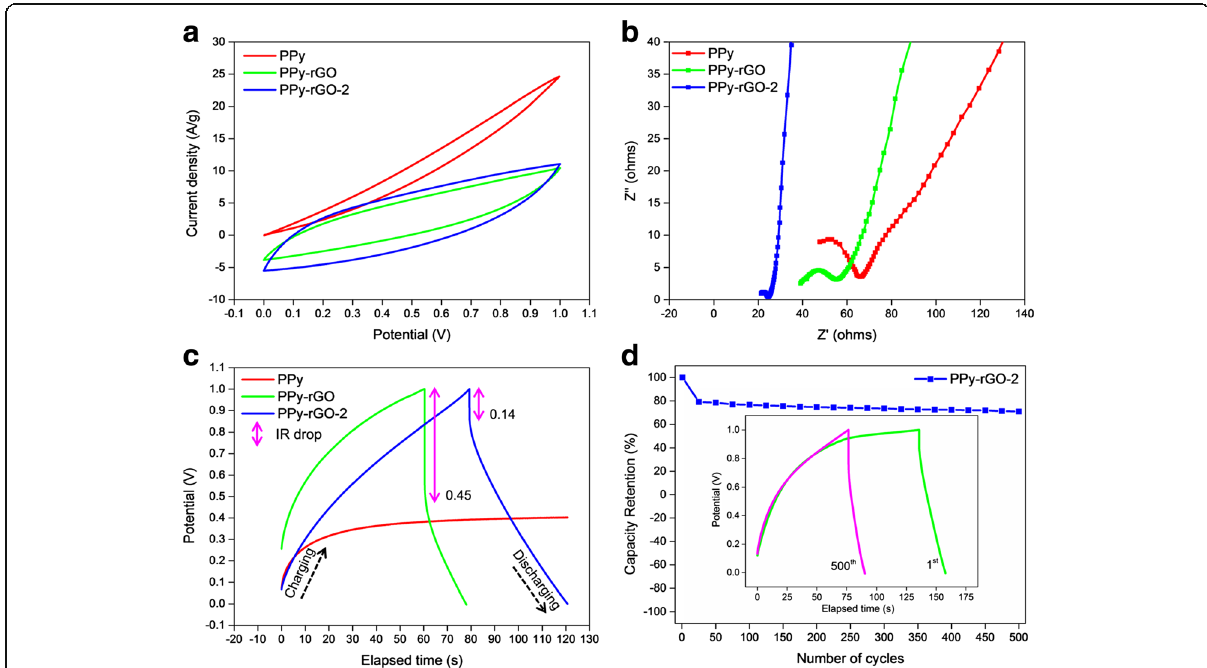
Fig. 5 Electrochemical performances of CBF/PPy, CBF/PPy-rGO and CBF/PPy-rGO-2 modified carbon bundle fibre-based symmetrical solid-state supercapacitor devices. a CV curves at scan rate of 100 mV s − 1 . b Nyquist plots. c Galvanostatic charge/discharge profiles at a current density of 1